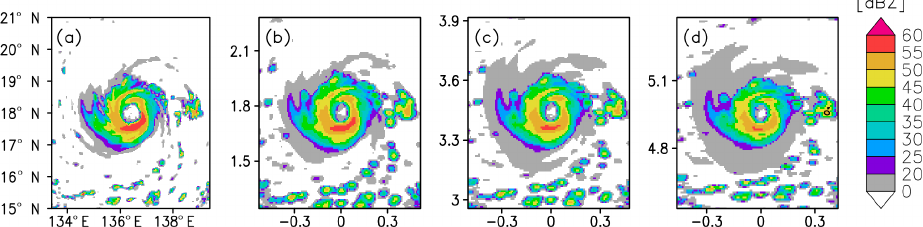
Figure 11. Precipitation reflectivity (dBZ) measured with bw20bs05 for the typhoons whose center is in (b) 10 ◦ N, (c) 20 ◦ N, and (d) 30 ◦ N. Contours in ( b )–( d ) correspond to the area in which the SCR>0. Panel (a) shows the truth. The areas where reflectivity from precipita- tion<0dBZ are left